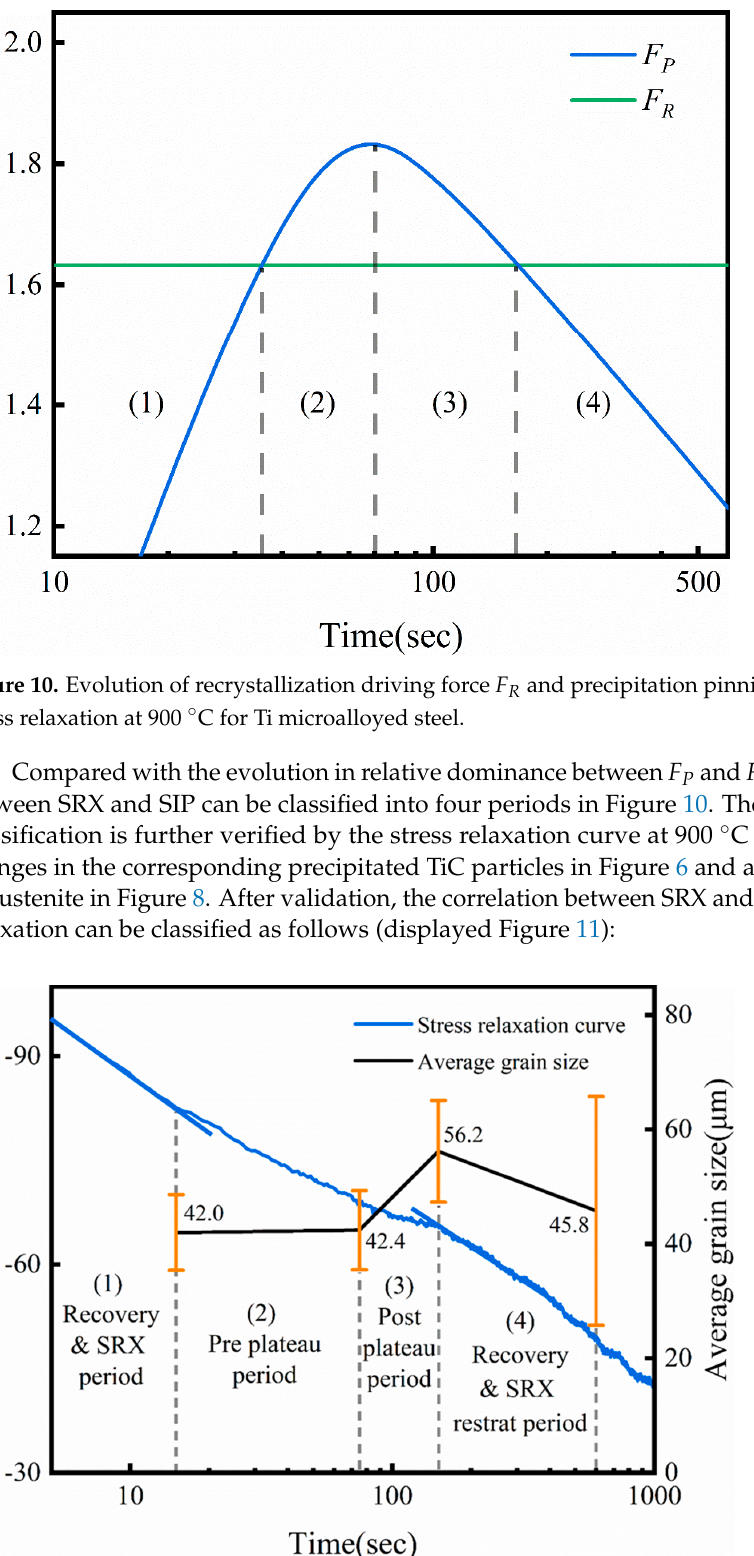
and isothermal holding time have been found to significantly influence this correlation.